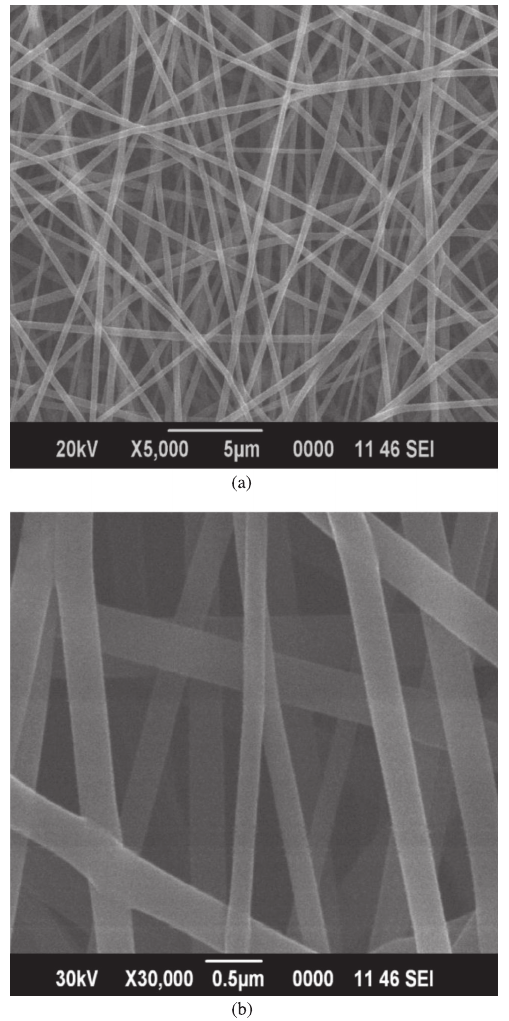
Figure 3. Scanning electron micrograph of electrospun PVA/SiO nano fibers at different magnifications (5 µ m and 0.5 µ